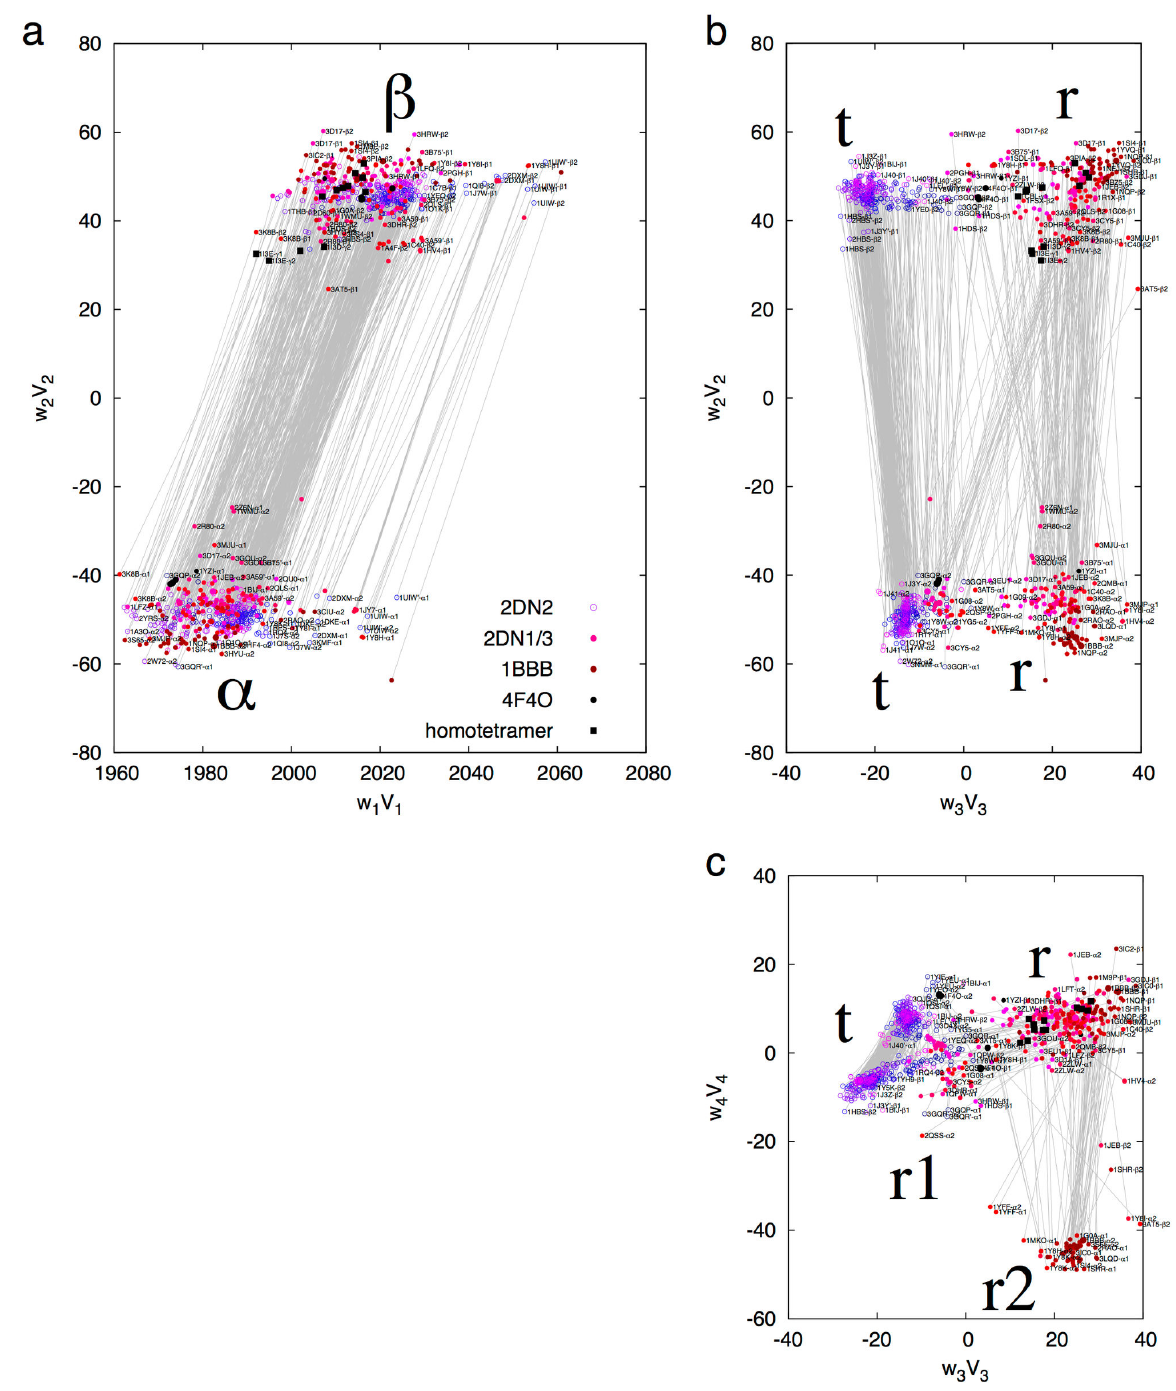
Figure 3. Combined conformational space of α and β. SVD is performed on more than 1,000 distance matrices of the equivalent residues of α and β. The 5-residue insertion in CDβ and 2-residue insertion in ABα are excluded in the calculation. The coefficient sets w V with k = 1, …, 4 are plotted in a - c . The continuous color scheme is the same as in Figure 2. In addition, all k k subunits on T side of the allosteric taboo gap are represented by open circles, and those on R side are in solid dots. Four subunits from the structure of free dimers (4F4O) are in black dots. Those β and γ subunits from the abnormal homotetrameric Hbs are in black squares. Two subunits from a same dimer are linked by a gray line. PDB entries are labeled by small typeface whenever possible, and are only visible on a digital copy. The decomposed lower triangles are in Figure S8. doi: 10.1371/journal.pone.0077141.g003 PLOS ONE |